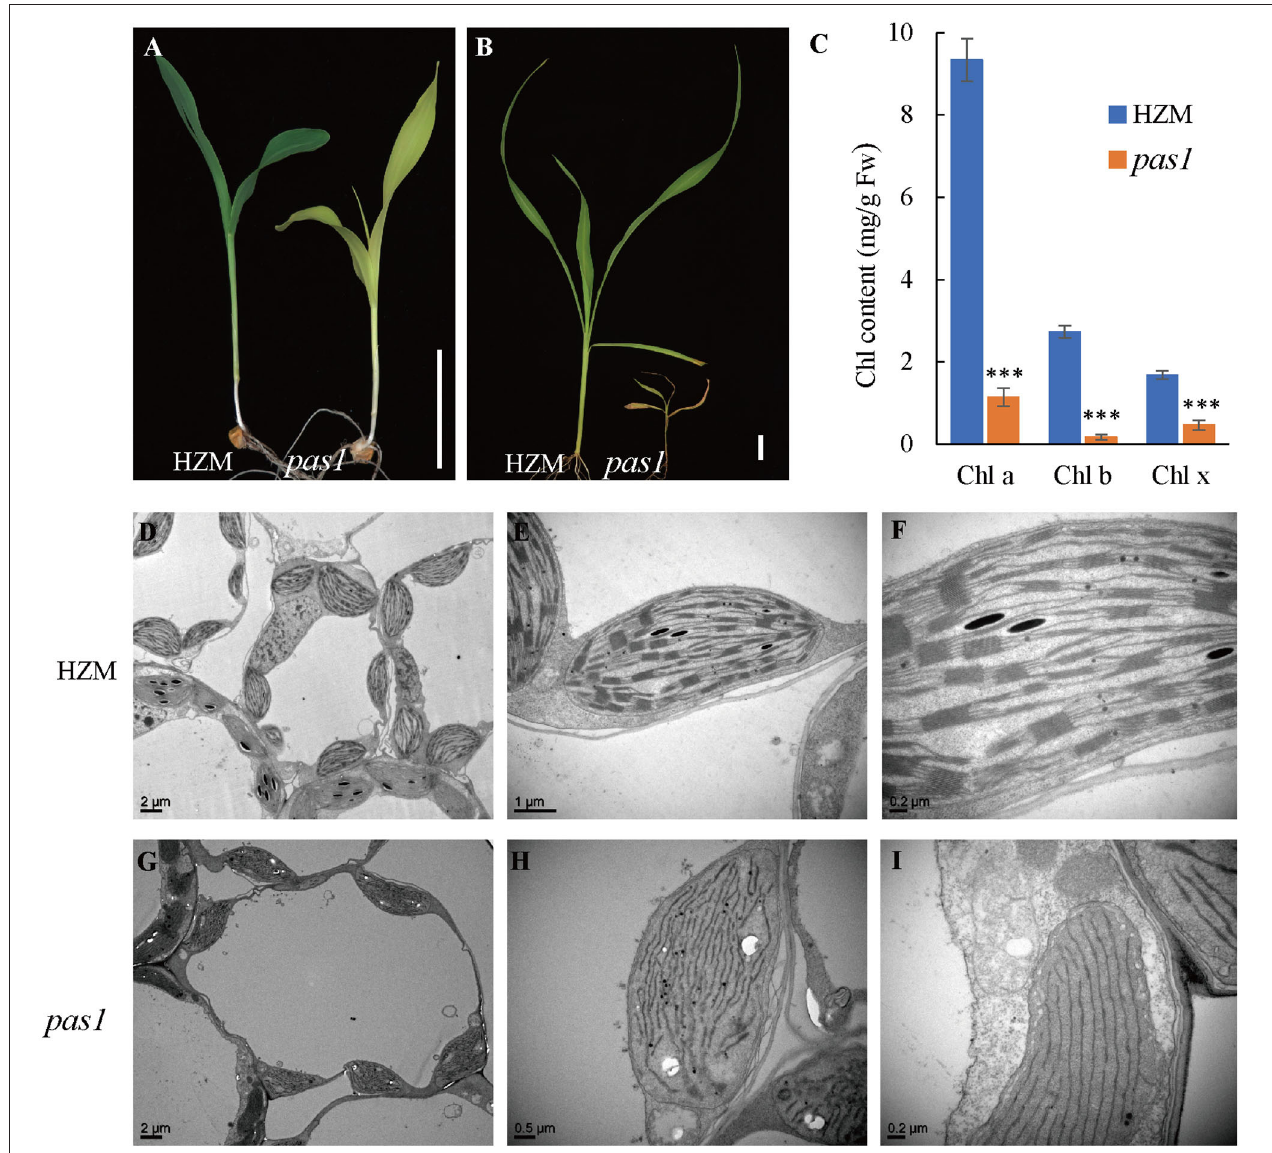
FIGURE 1 | pas1 is defective in plant growth and chloroplast development. (A) , Phenotype of wild-type and pas1 mutant at the 3-leaf stage. Bar = 3cm. (B) , Phenotype of the wild-type and pas1 mutant at the 4-leaf stage. Bar = 3cm. (C) , The chlorophyll contents of the wild-type and pas1 mutant. (D–I) , Transmission electron microscopy for chloroplast structure of the wild-type and pas1 . (D–F) , HZM; (G–I) , pas1 .